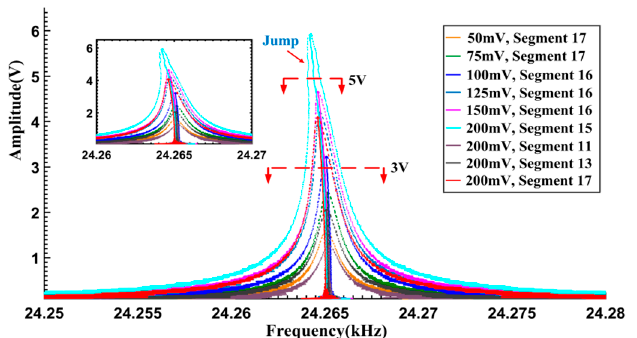
Figure 12 . Backbone curves cluster and FRF curves cluster.